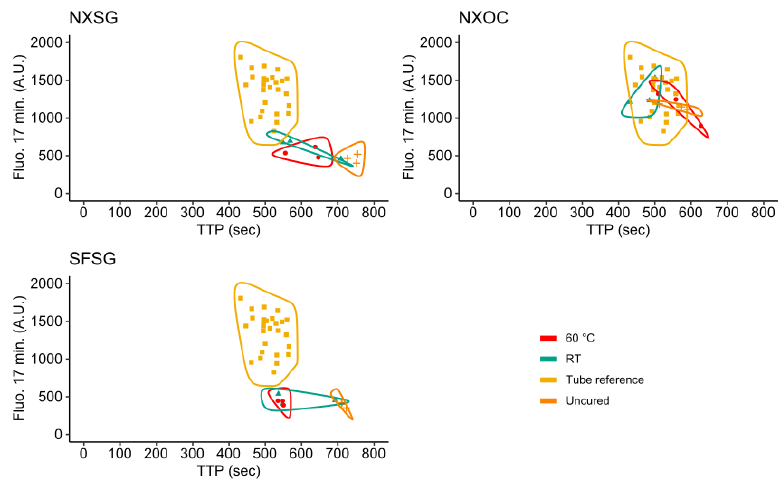
Figure 8. Scatterplot of the time to positive (TTP) value against the final background corrected fluorescence after 17 min for all investigated 3D printing materials and post curing conditions.